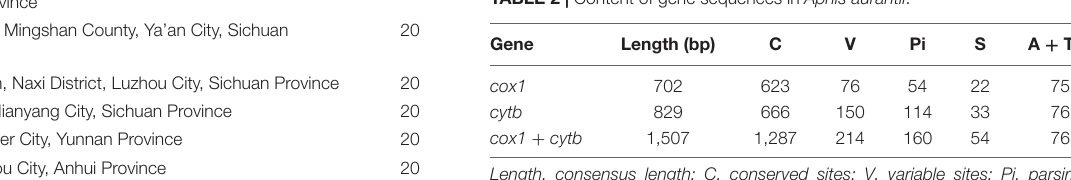
TABLE 2 | Content of gene sequences in Aphis aurantii